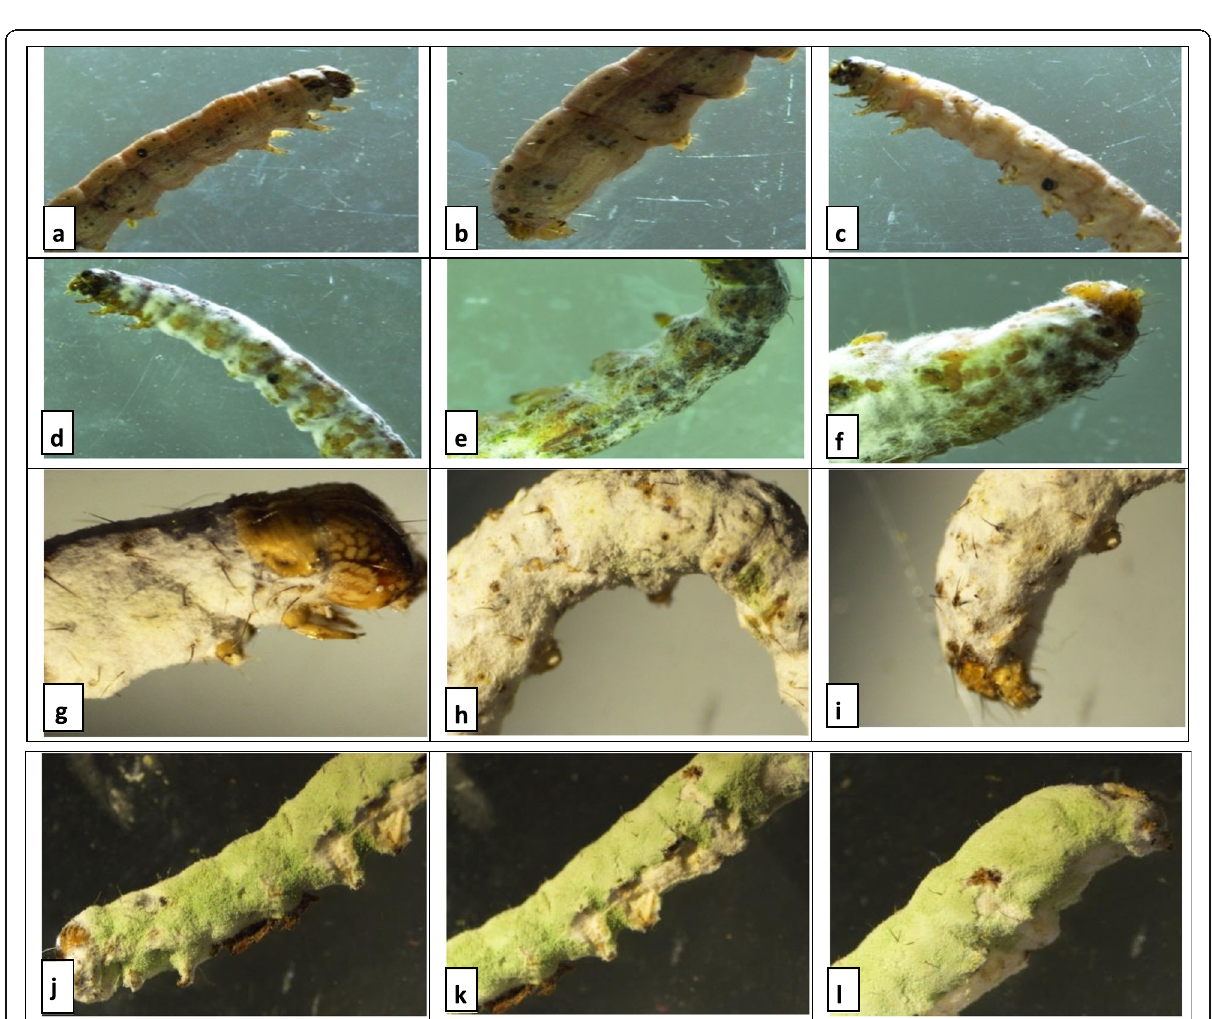
Fig 4 Development of mycosis of Metarhizium rileyi on larval instars of Spodoptera frugiperda : colour of the larval instars turned straw in colour and were killed 4 days after topical application with M . rileyi ( a – c ), progress of infection ( d – f ), flocullent whitish growth of fungus on larval instars 8 days after inoculation ( g – i ), and sporulation of M . rileyi on S . frugiperda 10 days after inoculation ( j – l )